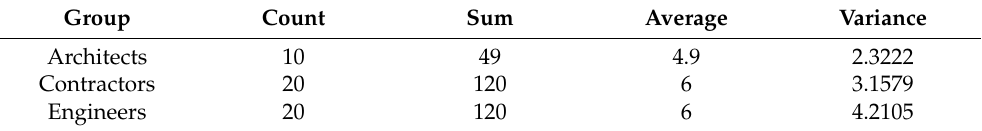
Table 2. One-way ANOVA of the influence of respondents over the selection of construction materials. Group Count Sum Average